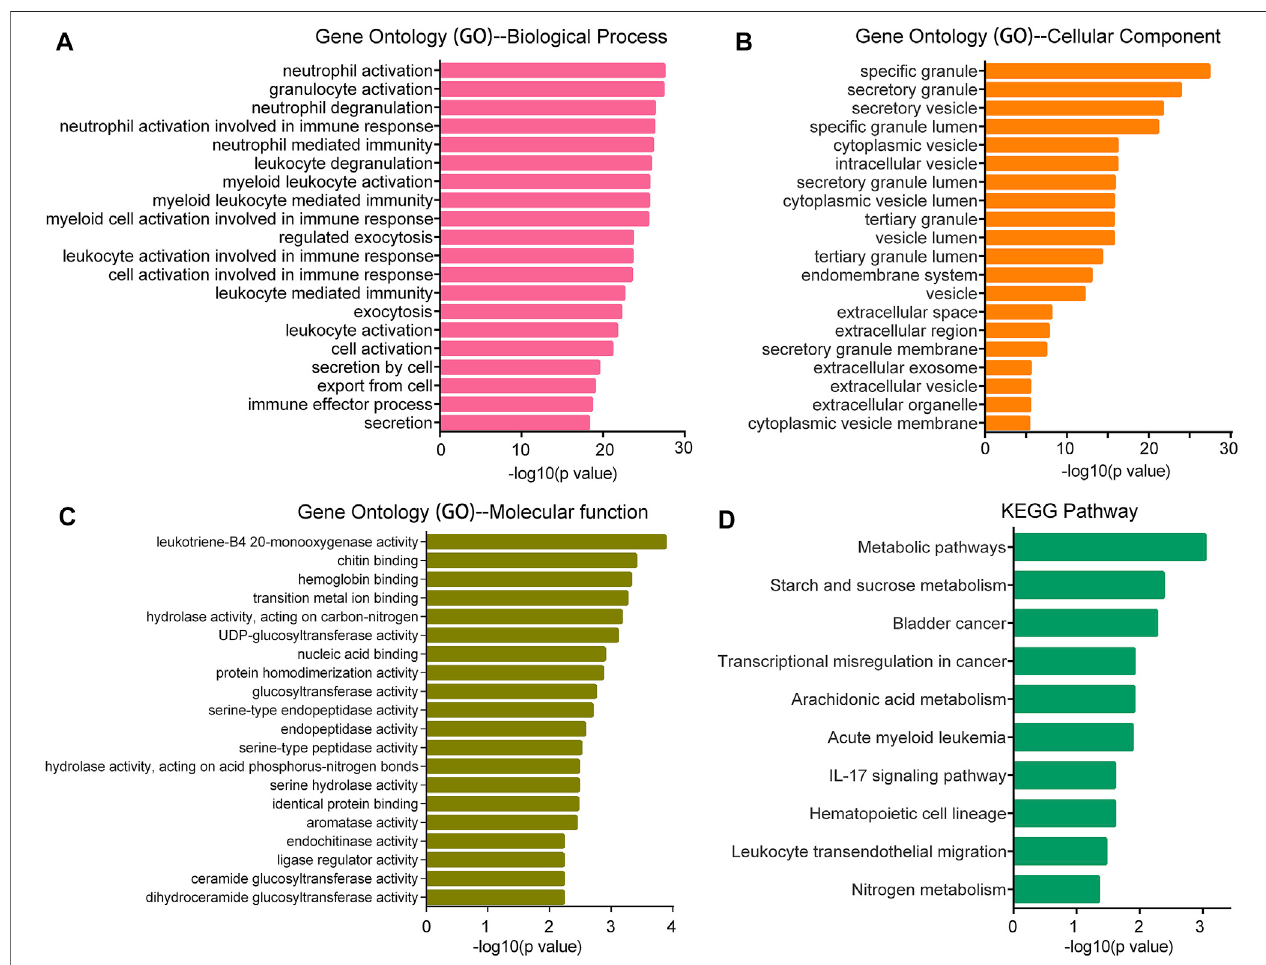
FIGURE 6 | GO and KEGG pathway enrichment analysis for the SMPDL3B correlated genes. The top 20 most enriched GO biological process (A) , GO cellular component (B) , GO molecular function (C) categories, and the top 10 most enriched KEGG pathways (D) are plotted.